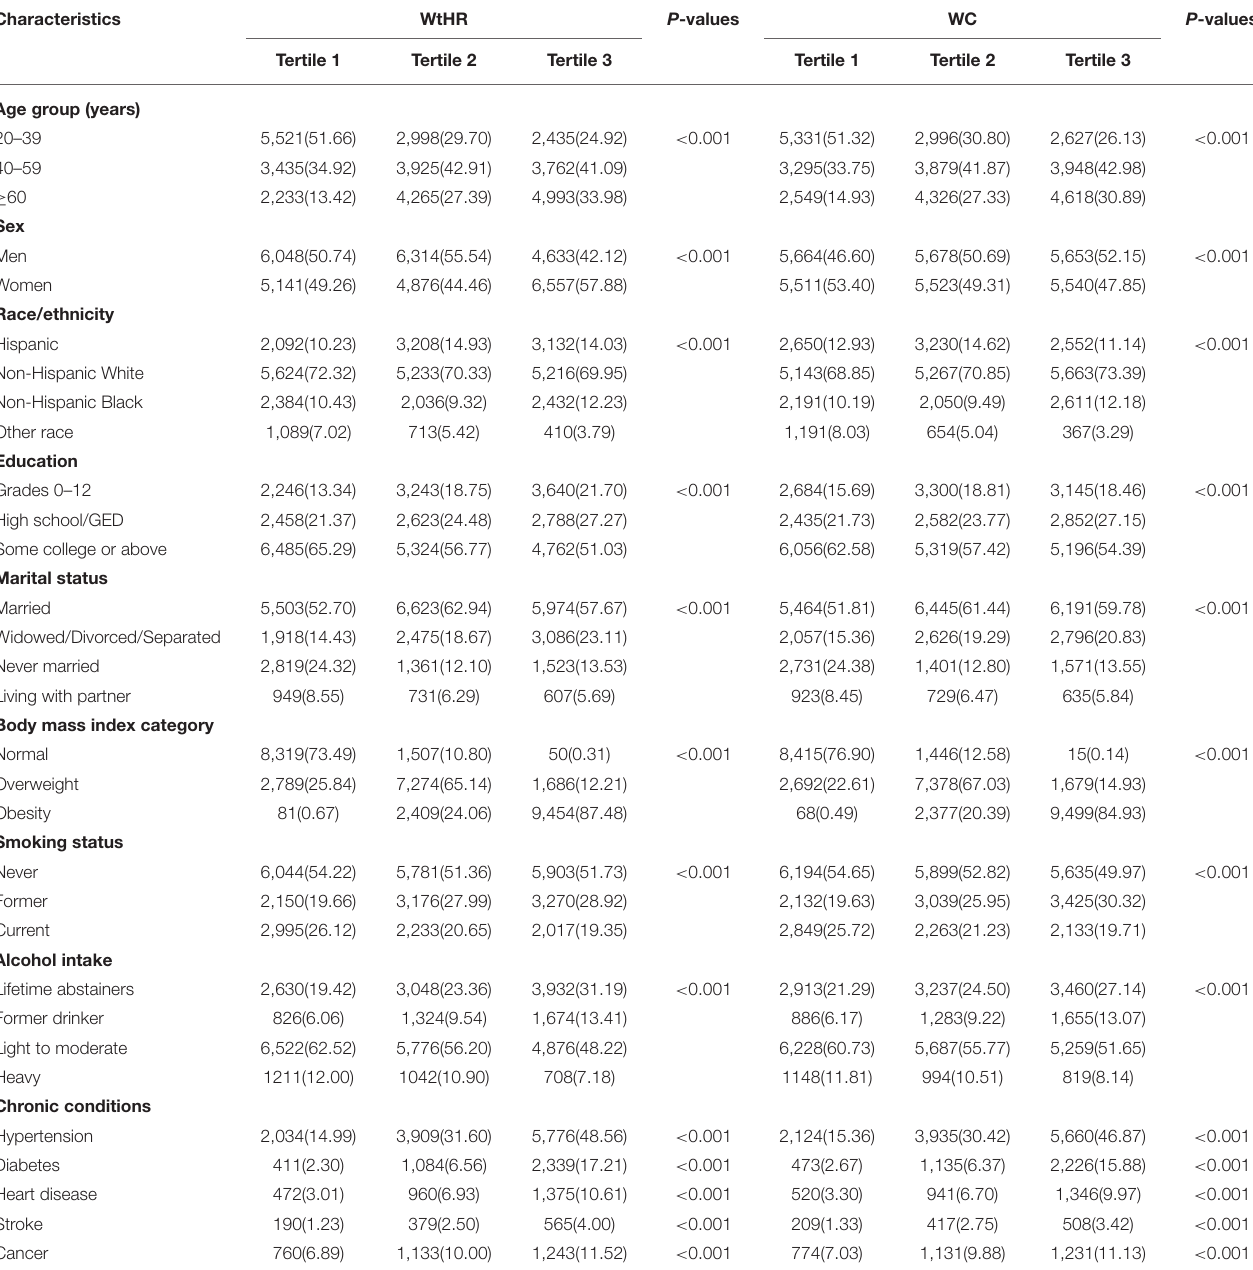
TABLE 1 | Characteristics of study adults according to baseline measures of the WtHR and WC in the National Health and Nutrition Examination Survey, 1999–2014. Characteristics WtHR P